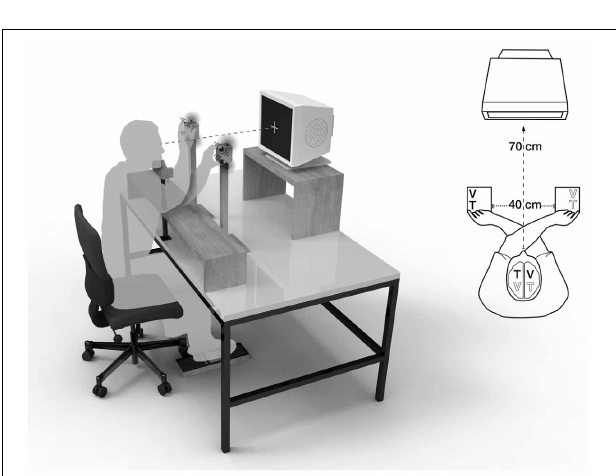
FIGURE 2 | Visuotactile crossmodal congruency task with crossed hands. A central fixation cross was displayed at a distance of 70cm, the distance between hands was 40cm. V, visual distractor; T, tactile